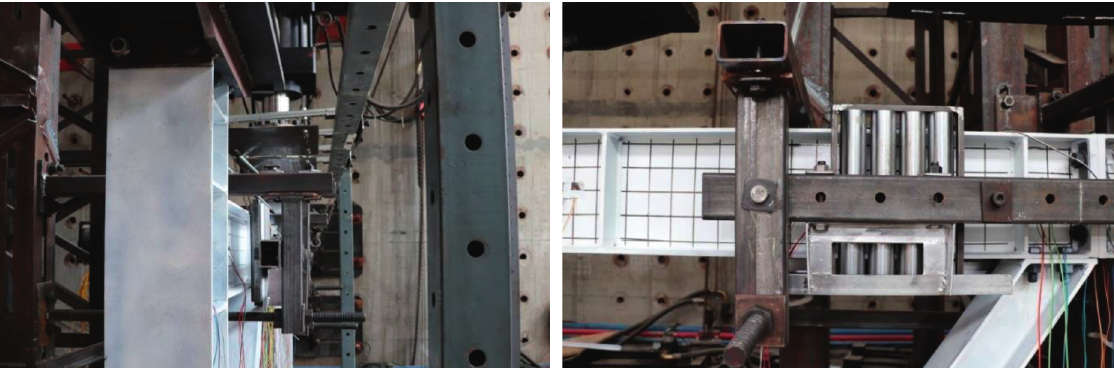
Figure 6: Out-of-plane deformation limiting device.